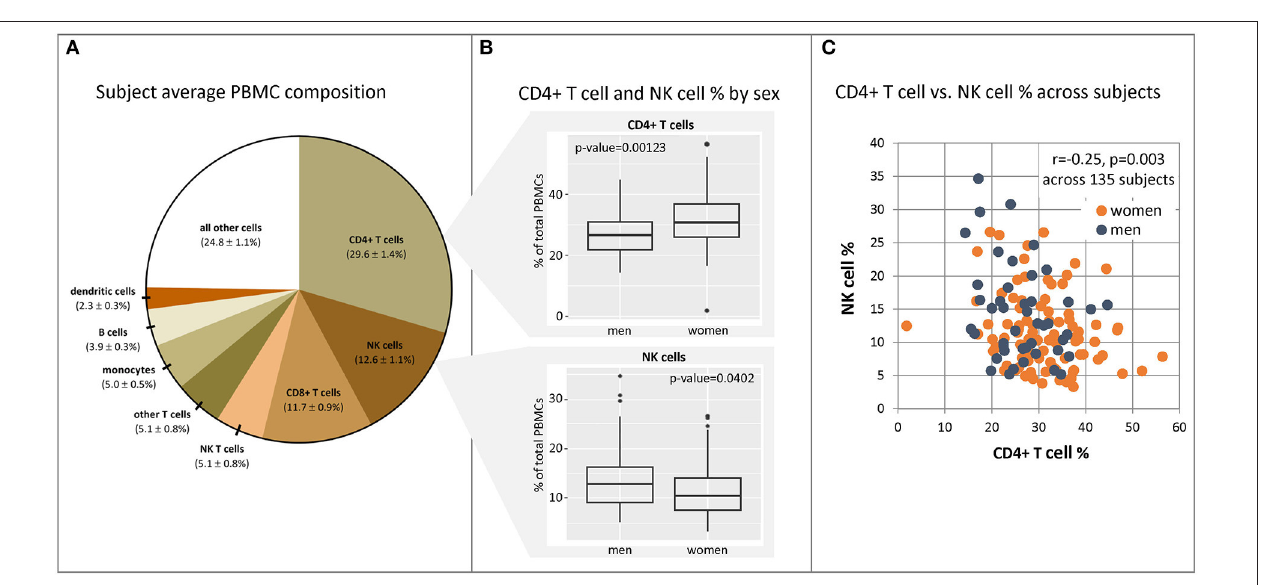
Frontiers in Immunology |